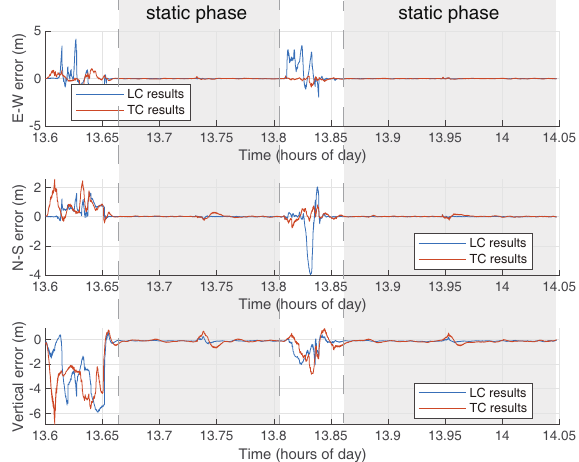
Figure 5: 3-dimensional error plots of track 1 in